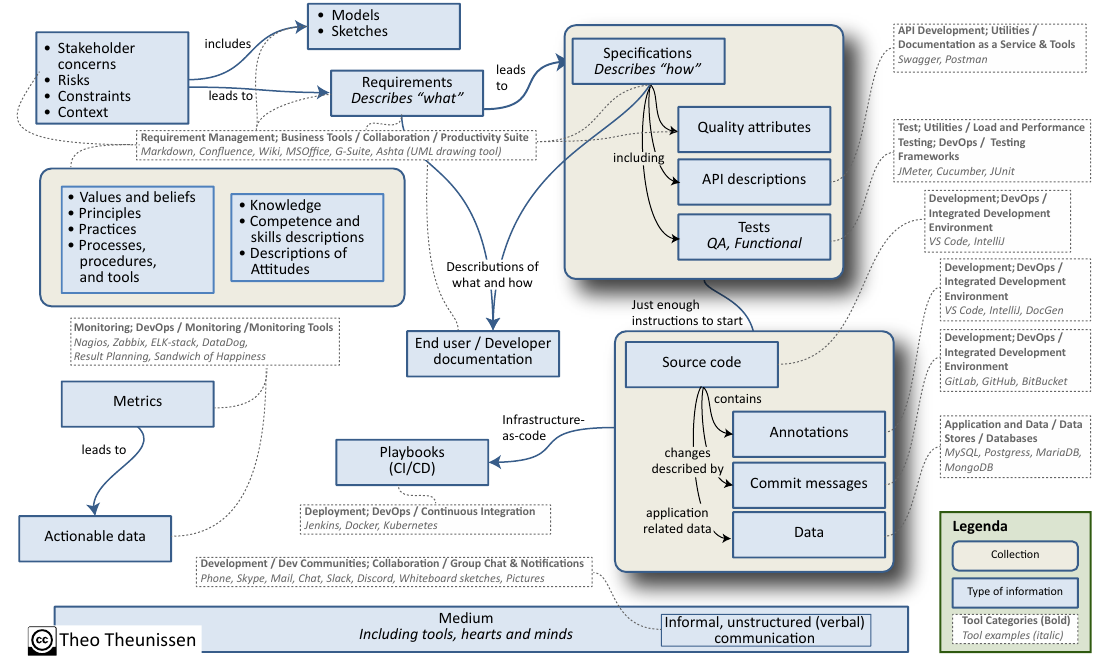
Figure 2. Types of Information including mapping to tool categories and tools